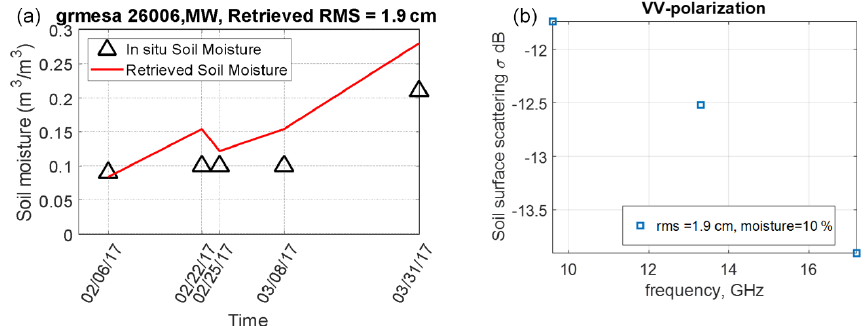
Figure 6. (a) Retrieval of soil moisture compared with in situ measurements. The retrieved rms height is 1.9cm. The retrieval is based on based on L-band UAVSAR data from the SnowEx 2017 campaign. The measured soil moisture is from SnowEx 2017 campaign meteorolog- ical observations with a measured soil temperature of 0.6 ◦ C. The location of the station is 39.03388 ◦ N, 108.21399 ◦ W, with an elevation of 3033m. (b) Simulated surface scattering with snow attenuation from X- to Ku-band at VV polarization. Snow parameters are with depth of 54cm, density of 183kgm − 3 , (cid:104) ζ (cid:105) = 1 . 2mm, and b = 1 . 2. Blue marks are based on the SnowEx 2017 campaign data shown in (a) .